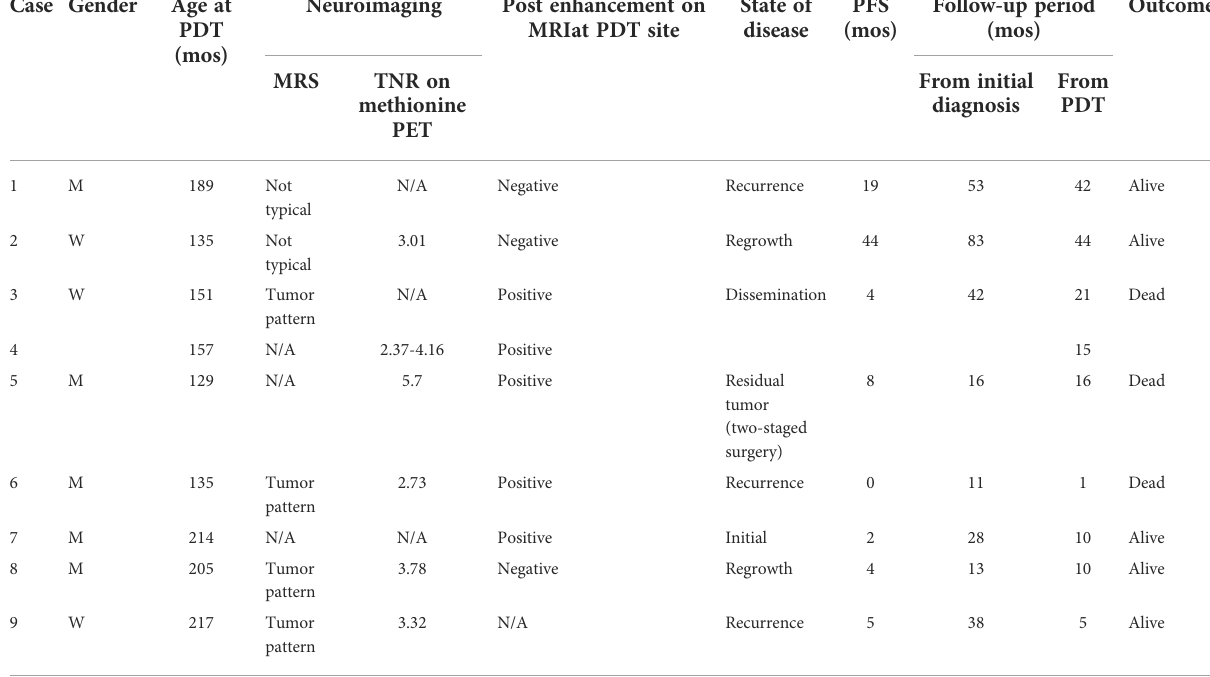
TABLE 1 Summary of characteristics of patients, neuroimaging, state of disease, follow-up period, and outcome. Case